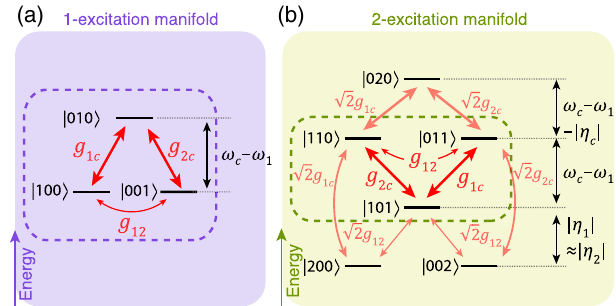
FIG. 17. Energy level diagrams of the single-excitation mani- fold (a) and the double-excitation manifold (b) when performing the iSWAP gate. The dashed boxes indicate subspaces spanned by energy levels that are relevant to coherent leakage during the iSWAP gate. The red double-headed arrows denote exchange interactions between the energy